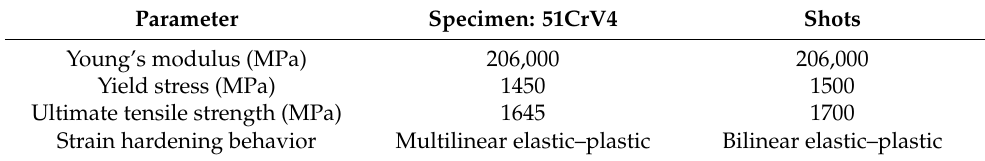
Table 1. Fundamental material values for specimen and shots. Parameter Specimen: